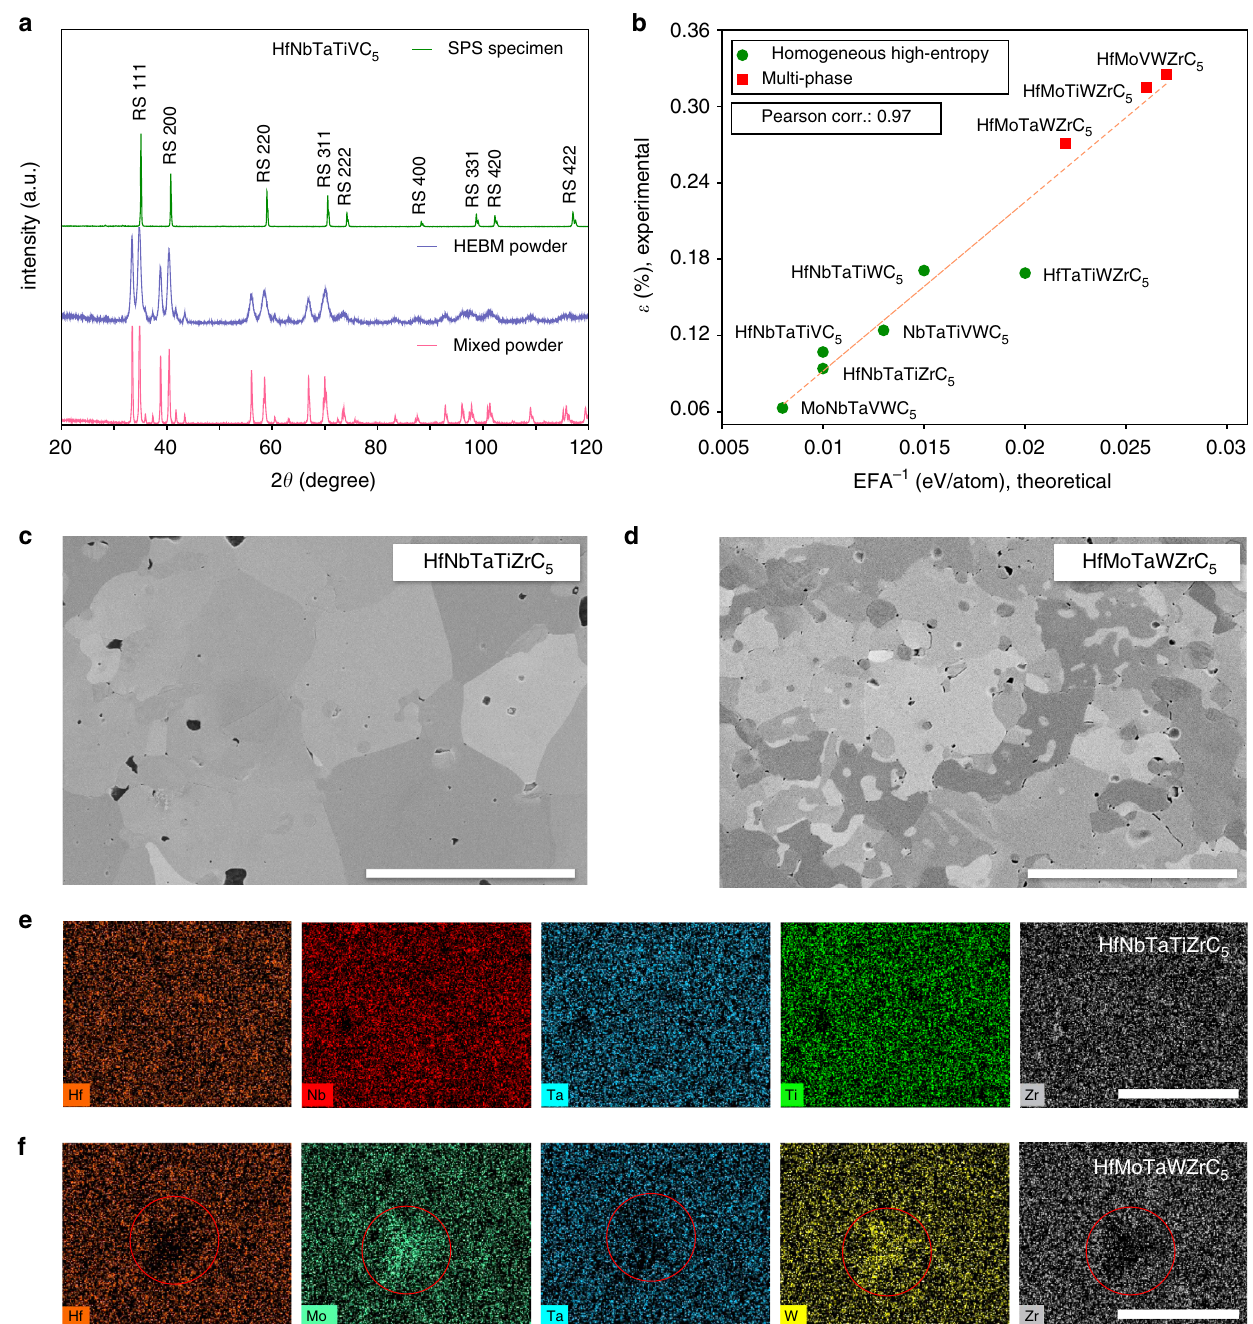
Fig. 2 Experimental results for high-entropy carbides synthesis and characterization. a Progression of a sample of HfNbTaTiVC 5 through each processing step: hand mixing (magenta spectrum, bottom), ball milling (blue spectrum, center), and spark plasma sintering (green spectrum, top), depicting the evolution towards the desired rock-salt crystal structure ( a exp = 4.42 Å). b Linear relationship between EFA − 1 and the distortion of experimental lattice parameters ε . Green circles and red squares indicate homogeneous high-entropy single- and multi-phase compounds, respectively. c , d Electron micrographs of single-phase HfNbTaTiZrC 5 and multi-phase HfMoTaWZrC 5 specimens. e , f Selected EDS compositional maps of the HfNbTaTiZrC 5 and HfMoTaWZrC 5 specimens. The micrographs show the presence of the secondary phase in HfMoTaWZrC 5 (circles) that is also present in XRD results, which is revealed to be a W- and Mo-rich phase. Scale bars, 10 μ m ( c – f HfMoTaWZrC 5 , HfMoTiWZrC 5 , and HfMoVWZrC 5 (the bottom 3) show multiple structures. The small peaks at 2 θ = 31.7°, marked